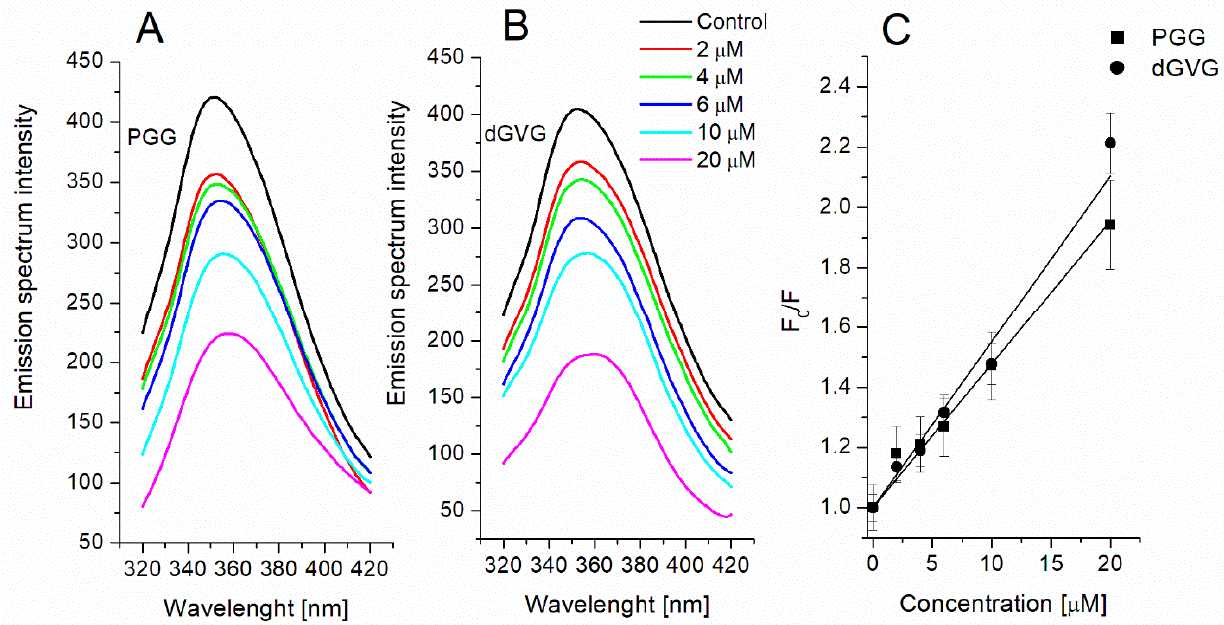
Figure 6. Fluorescence spectra of S. aureus membrane proteins without and in the presence of PGG ( A ) and dGVG ( B ) with the Stern–Volmer plots of tryptophan quenching ( C ). The data presented are the means ± SD, n = 6.